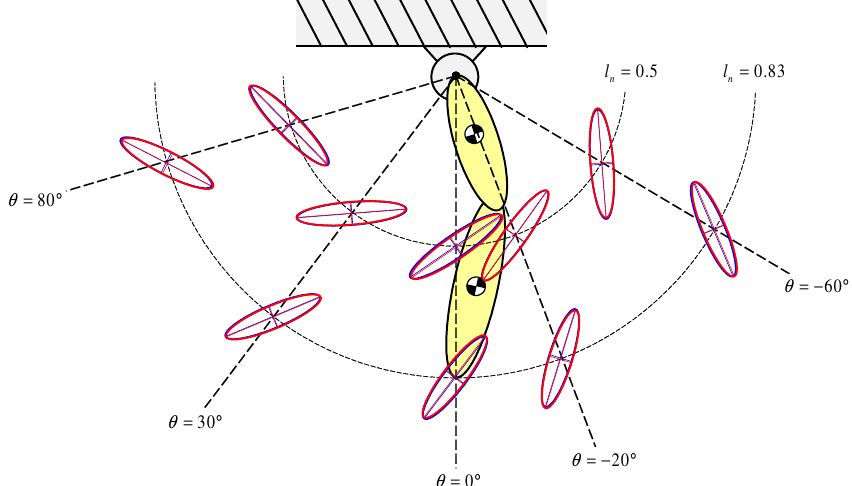
Figure 8. CIEs depending on the actuator configuration: serial (red) and parallel (blue).